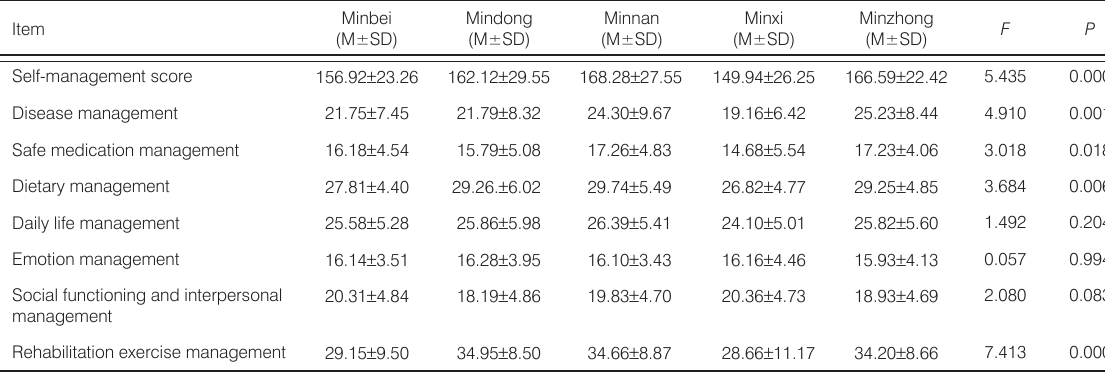
Table 2. Self-management behavior scores of Mindong, Minxi, Minnan, Minbei, and Minzhong, Fujian province ( n